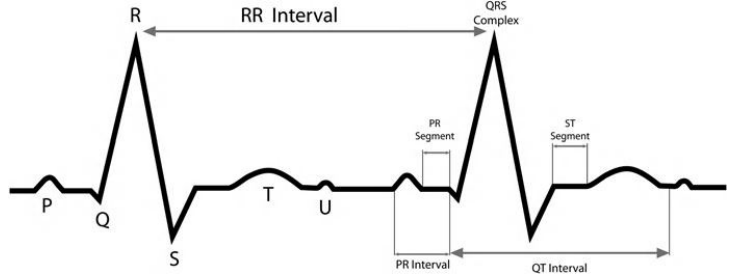
Fig. 1.5 The ECG waves, segments, and intervals Figure 1. The ECG waves, segments, and intervals